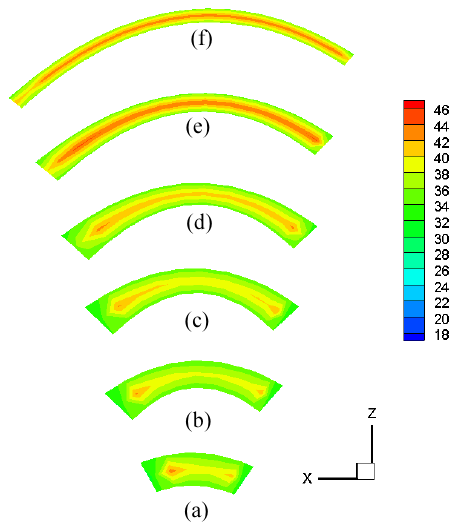
Fig. 6. Temperatures distribution at different levels of the dam at the end of construction